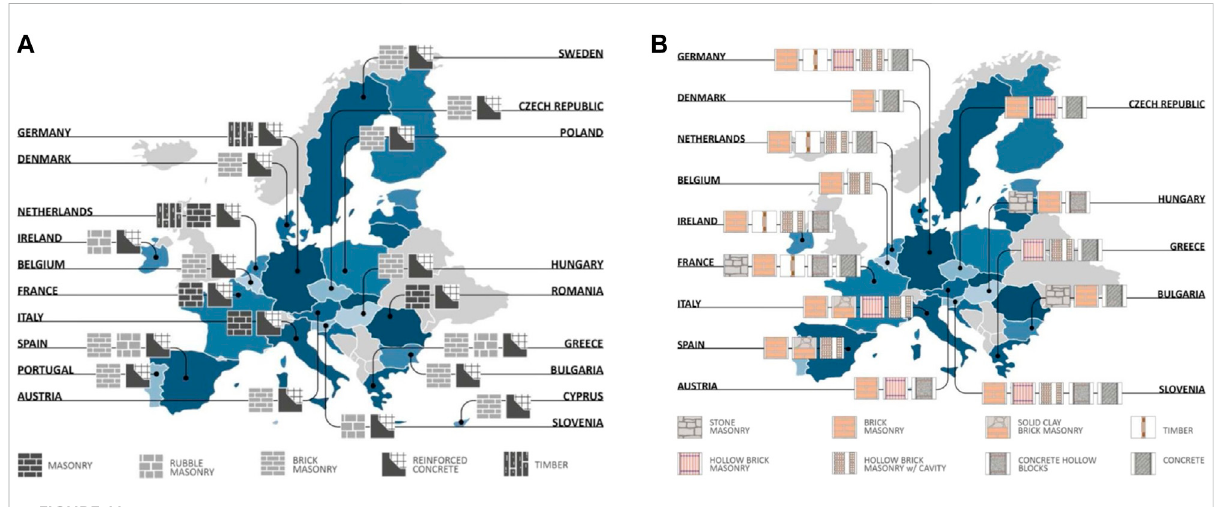
FIGURE 11 European building stock: (A) Building constructiontechnologies mapbasedon quantitative and qualitative data; (B) Typical in fi llwalls(Landolfo et al.,